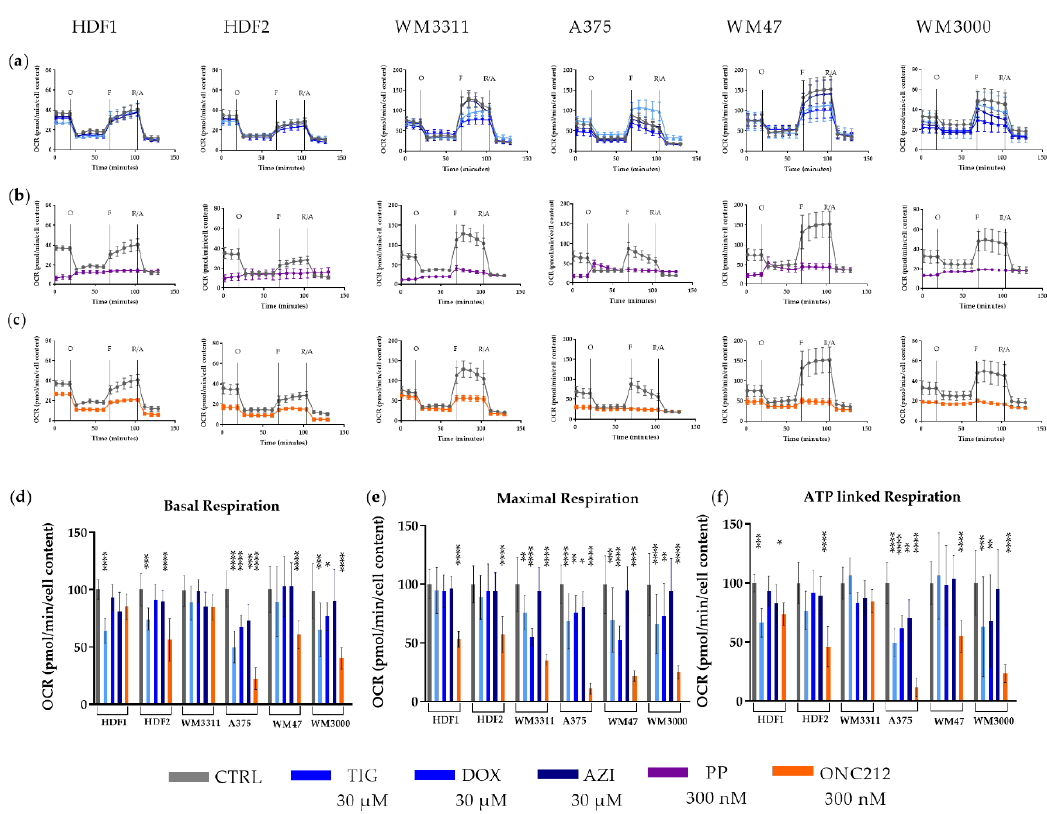
Figure 4. OCR measurements of ( a ) TIX-, DOX- and AZI-treated, ( b ) PP-treated, ( c ) ONC212-treated melanoma cells and HDFs compared to corresponding vehicle-treated cells during a mitochondrial stress test. Levels of ( d ) basal respiration, ( e ) maximal respiration, and ( f ) ATP-linked respiration in TIX-, DOX-, AZI- and ONC212-treated cells expressed relative to values of vehicle-treated cells normalized to 100%. Values are given as mean ± SD. One-way ANOVA followed by Dunnett’s Multiple Comparison Test; * p ≤ 0.05; ** p ≤ 0.01; *** p ≤ 0.001; **** p ≤ 0.0001. For every cell line, two independent measurements with 6 to 8 replicates were performed. Cells were treated with 30 µ M TIG, DOX and AZI, and 300 nM PP and ONC212. 5 µ M Oligomycin (O); 2 µ M FCCP (F); 0.5 µ M Rotenone and Antimycin A (R/A).